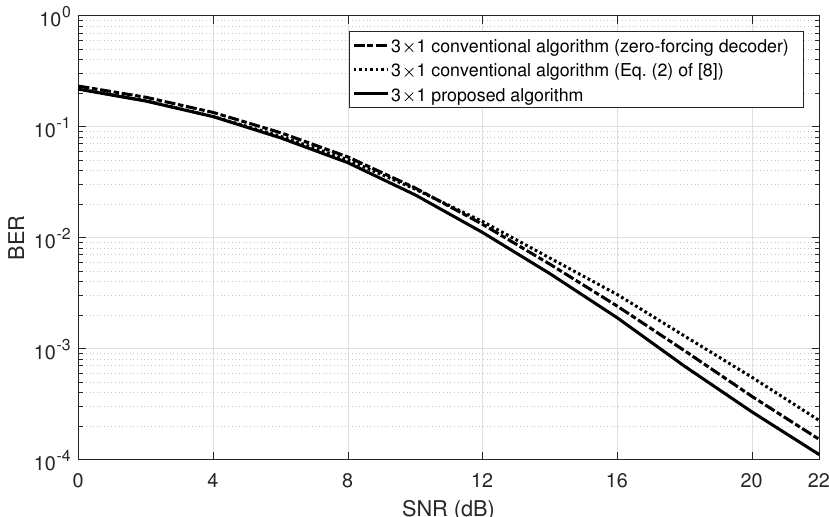
Figure 3. BER performance of the conventional QO-STBC and proposed algorithm as a function of the SNR for the three antennas system in a Rayleigh fading channel.